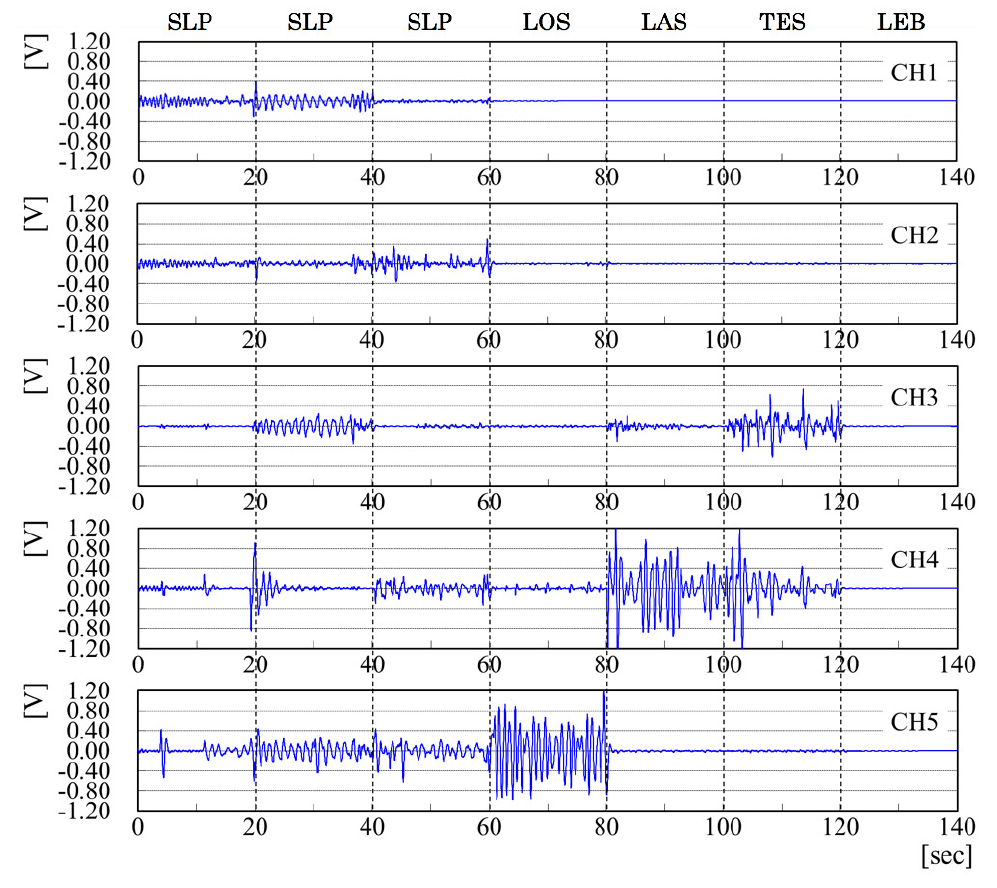
Figure 13. Output signals from pad